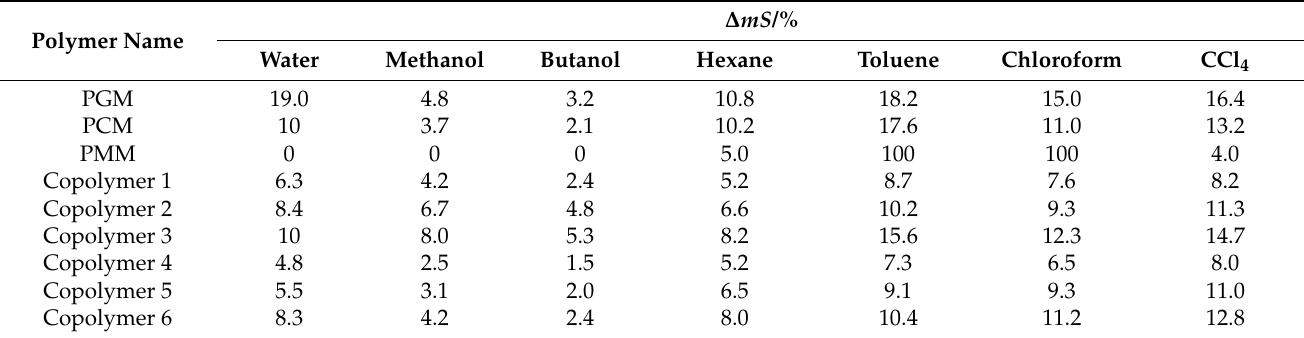
Table 4. Percentage change in mass ( ∆ mS) for samples conditioned at 50 ◦ C (series 1).